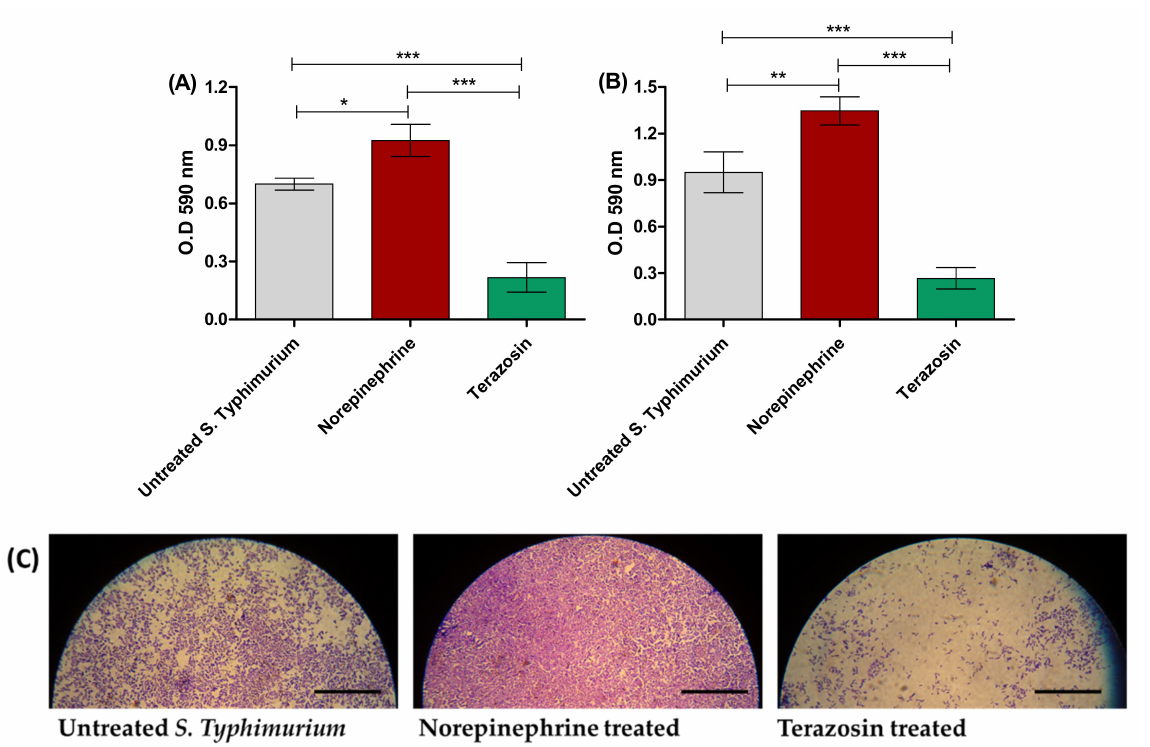
Figure 2. Terazosin diminishes S. Typhimurium ( A ) adhesion and ( B ) biofilm formation. Terazosin significantly decreased the bacterial adhesion and biofilm production in comparison to untreated bacteria or norepinephrine-treated bacteria. However, norepinephrine significantly increased bac- terial adhesion and biofilm formation. ( C ) Light microscope images of the formed biofilms in the presence of norepinephrine or terazosin. Norepinephrine markedly increased the formed biofilm and terazosin markedly diminished biofilm formation. The experiment was repeated in triplicate, and the data are presented as the mean ± the SD. A one-way ANOVA test, followed by Tukey’s multiple comparison post-hoc test, was employed to attest the statistical significance; p < 0.05 was considered significant. *** = p < 0.0001; ** = p < 0.001; * = p < 0.05. Scale bars correspond to 100 µ